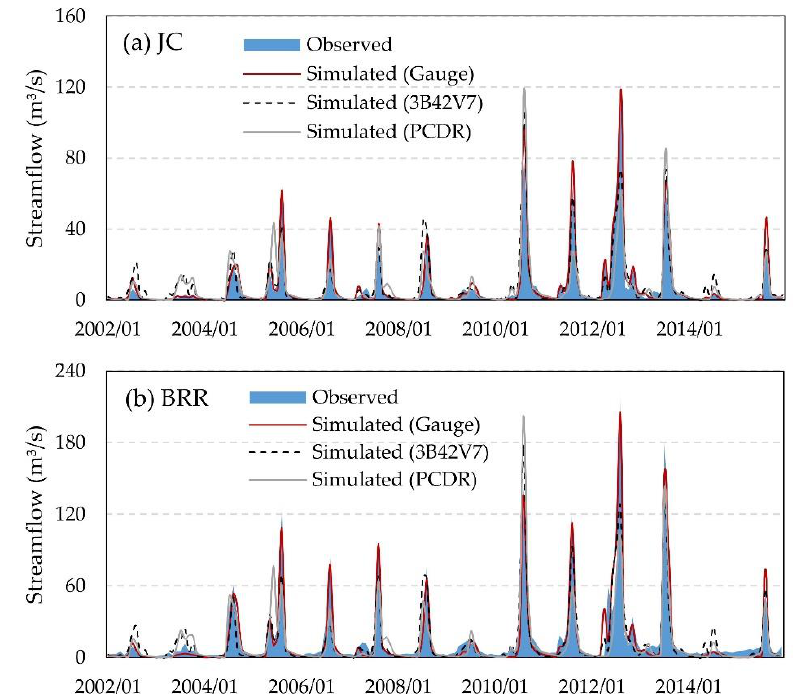
Figure 8. Simulated monthly hydrographs using the gauge precipitation, and the 3B42V7 and PCDR satellite precipitation datasets at ( a ) Jianchang (JC) station and ( b ) Biliu River Reservoir (BRR) station during the period 2002 to 2015.